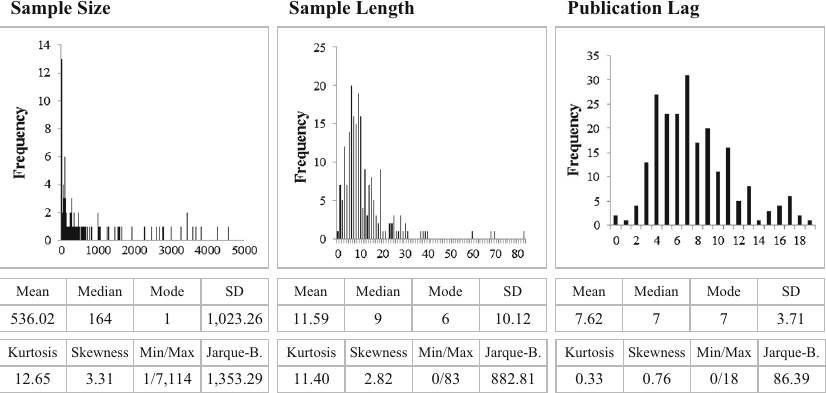
2.5% maximum outliers are dismissed from descriptive statistics. Fig. 2 Histograms of sample